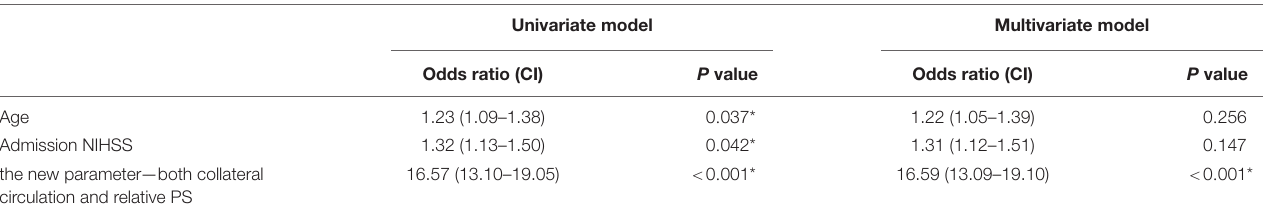
TABLE 2 | Univariate and multivariate logistic regression analysis for